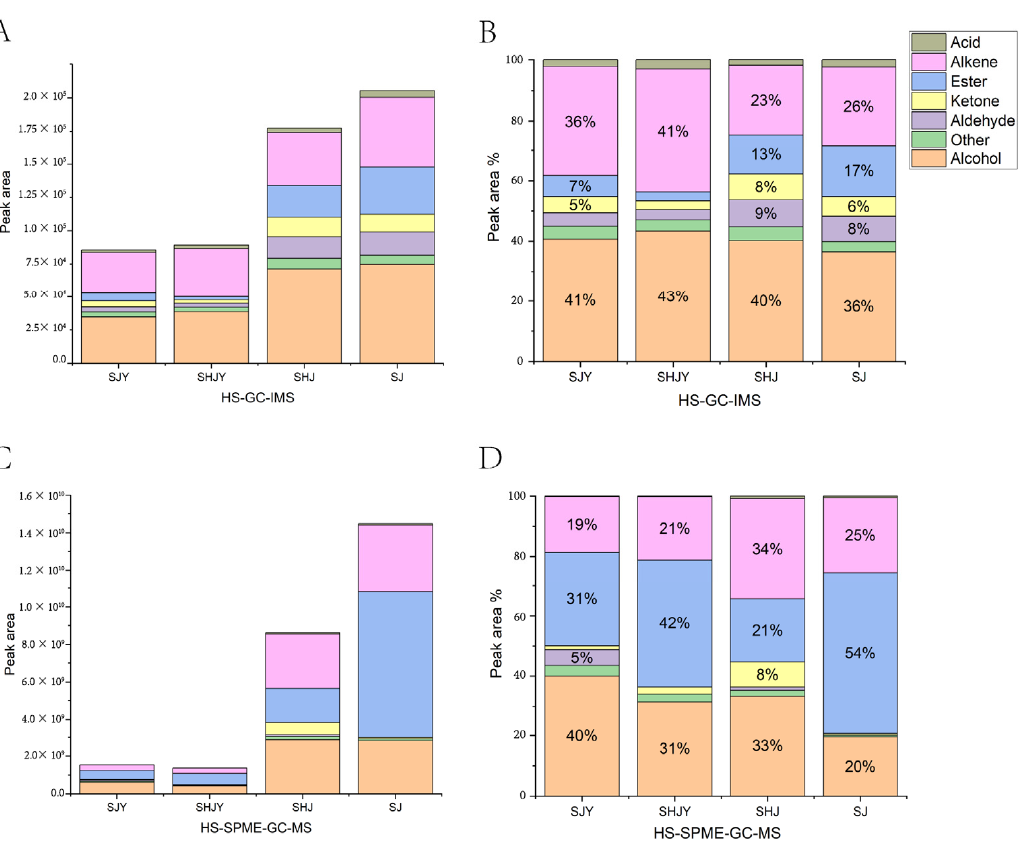
Figure 5. Percentage of component content of SHJ, SJ, SHJY, SJY. ( A , B ): the absolute and percentage